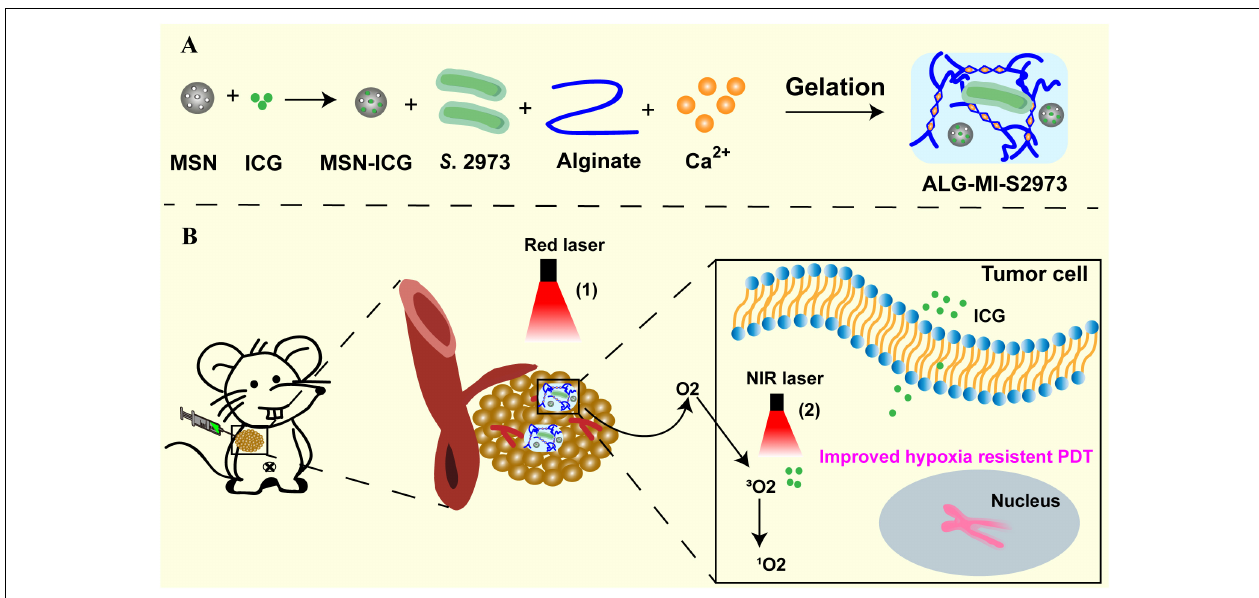
FIGURE 1 | Schematic illustration of the photo-oxygen-dynamic therapy. (A) S. 2973 and MSN loaded with photosensitizer ICG were mixed with sodium alginate to make injectable hydrogels (ALG-MI-S2973). (B) The hydrogels ALG-MI-S2973 was intratumorally injected and then formed gels at the tumor site. The tumor tissue was exposed to 640 nm laser to support survival of S . 2973 to generate O 2 , which alleviated the hypoxia microenvironment and further enhanced PDT effects. After releasing, ICG excited by 808 nm laser could exert efficient PDT effects to inhibit tumor growth. MSN, mesoporous silica nanoparticles; ICG, indocyanine green; ALG, hydrogels based on sodium alginate; MI, ICG-loaded MSN; ALG-MI-S2973, hydrogels packaging MSN-ICG and S .